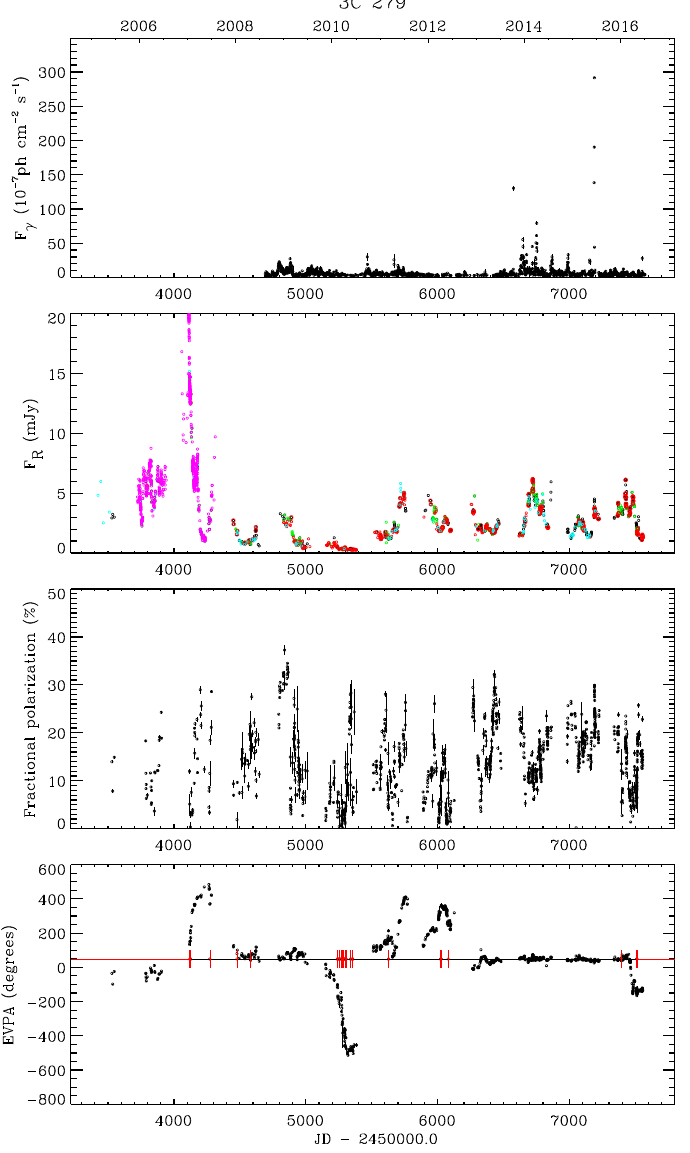
Figure 4. From top to bottom: Fermi γ -ray light curve, optical R-band brightness evolution, optical fractional polarization, and position angle of polarization of 3C 279 over the time interval 2006–2016. The red bars in the bottom panel mark positions of simulated false rotations (see